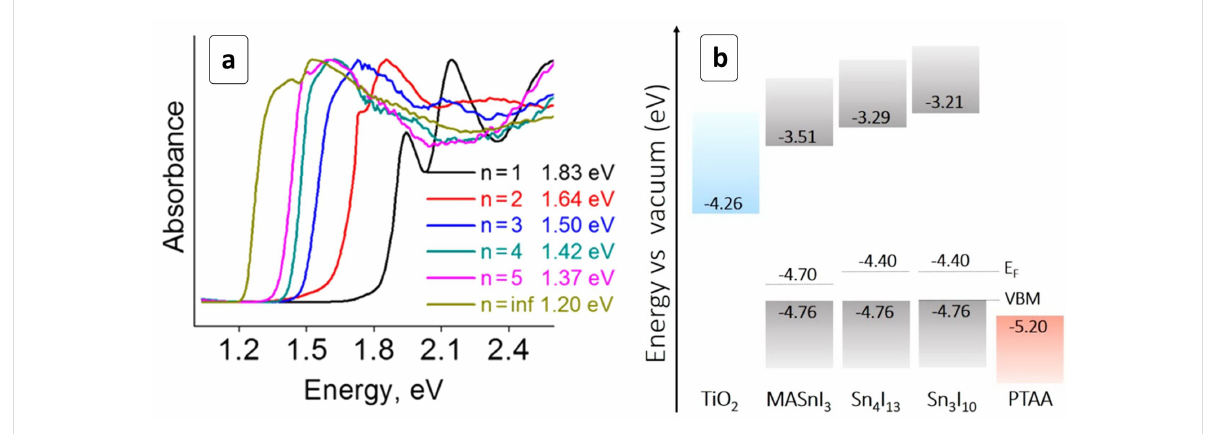
Figure 8: (a) Absorption spectra of (CH 3 (CH 2 ) 3 NH 3 ) 2 (CH 3 NH 3 ) n − 1 Sn n I 3 n +1 homological HPs; (b) energy level alignment in solar cells with selected HPs. VBM is the valence band (VB) minimum, E F is Fermi energy. Reprinted with permission from [75], copyright 2017 American Chemical Society.